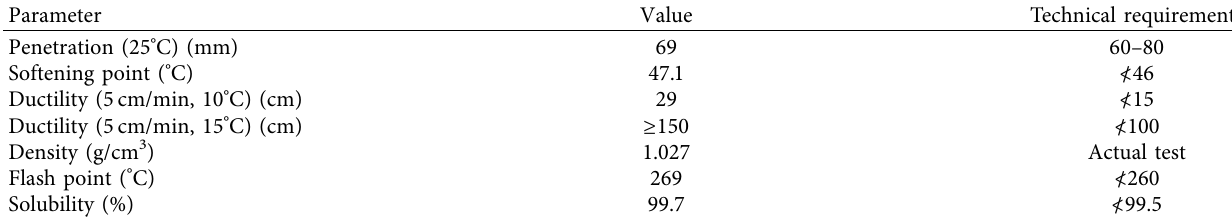
Table 2: Physical properties of 70#